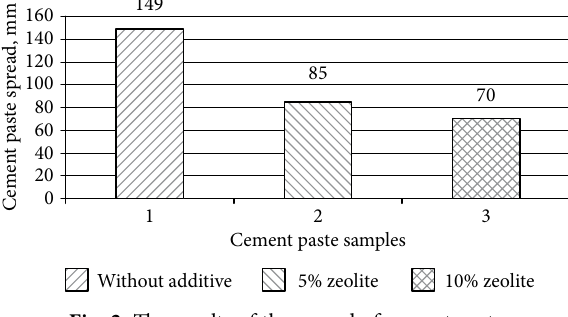
Fig. 2. The results of the spread of cement